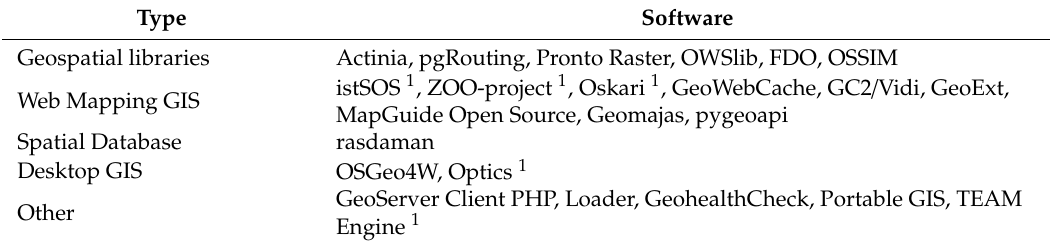
Table 2. Community projects by type of